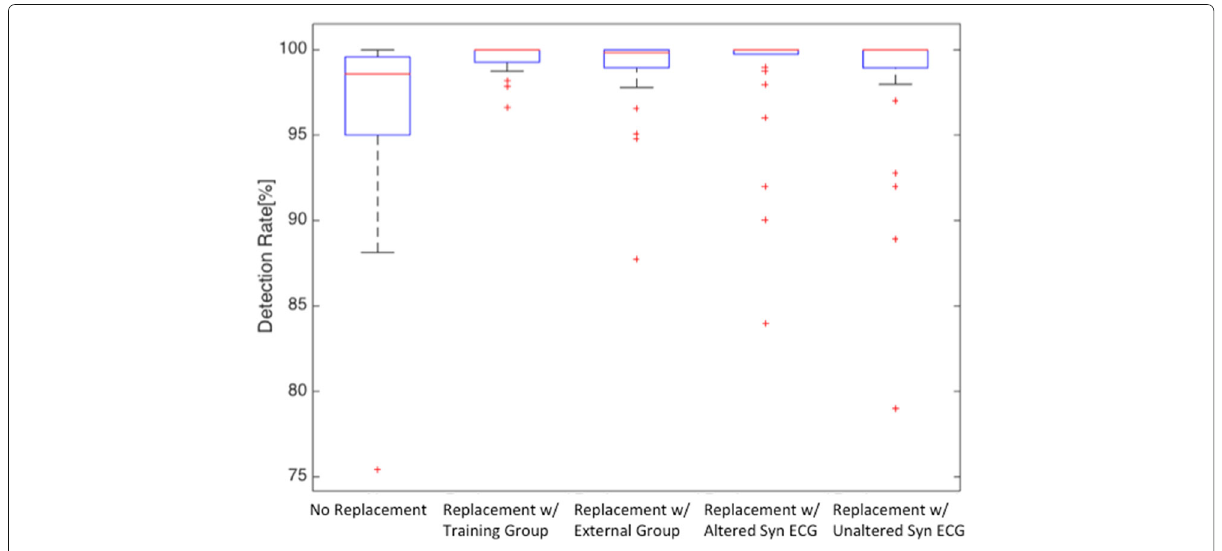
Fig. 16 Summary of detection accuracy for various attack scenarios